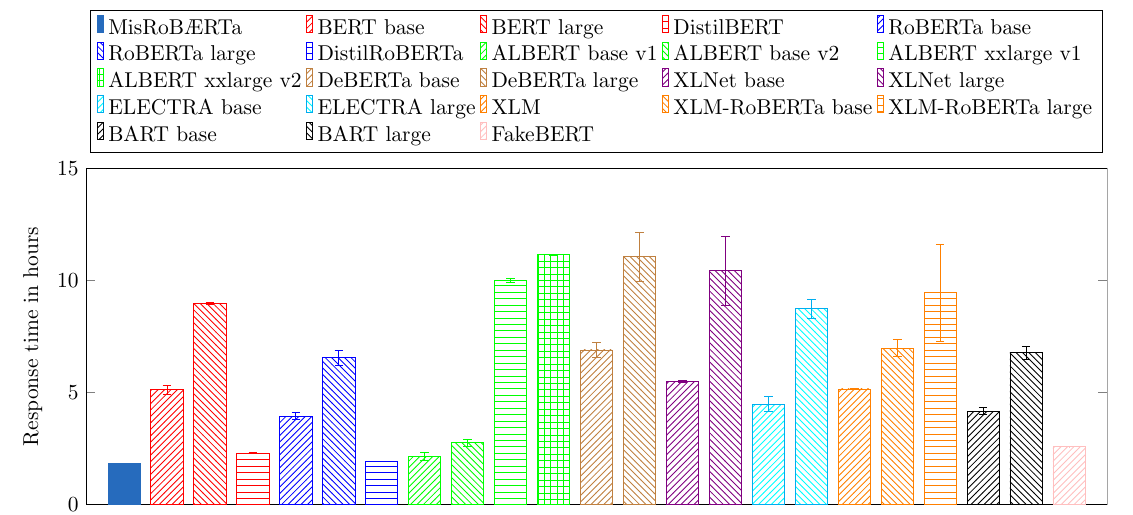
Figure 2. Performance time for the tested